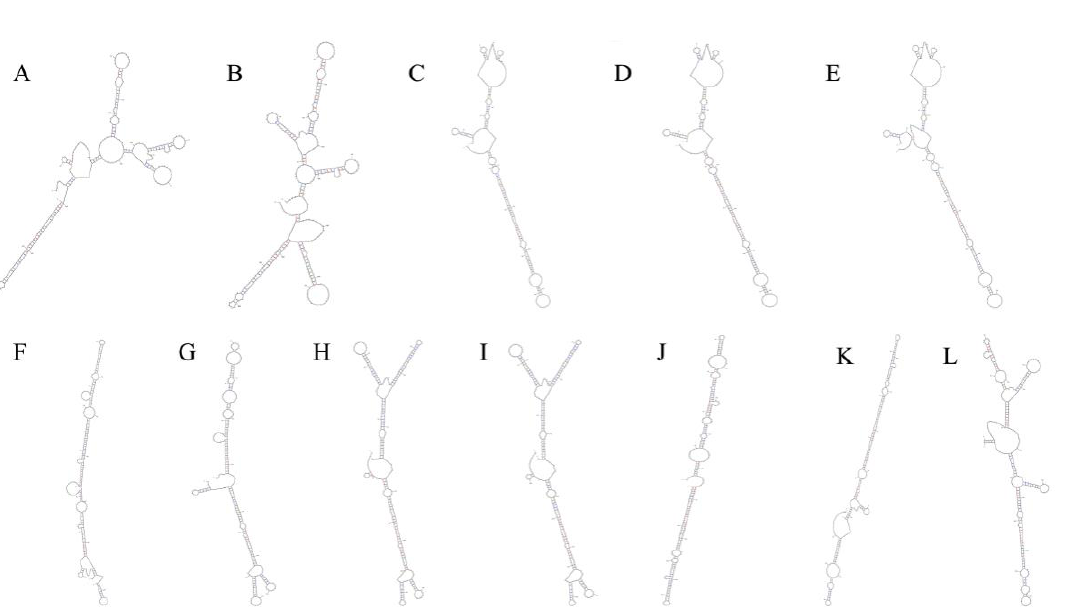
Figure 3. Sequences alignment among C. sinensis pre-miR166. Different highlight colors represent different homology levels of sequence. Green. ≥ 100%; O range. ≥ 75%; Blue. ≥ 50%.